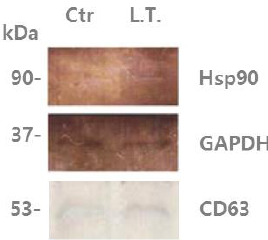
Figure 2. U-87MG exosome proteins were analyzed by immunoblotting using an antibody against Hsp90 and CD63. Left lane: “control”, non-treated U-87MG cell exosomes, which were incubated with 5% CO 2 at 37 °C for 4 days. Right lane: treated cell (L.T.) exosomes, which were exposed to 18 °C three times for 30 min during incubation with 5% CO 2 for the last 36 h of the 4-day period.